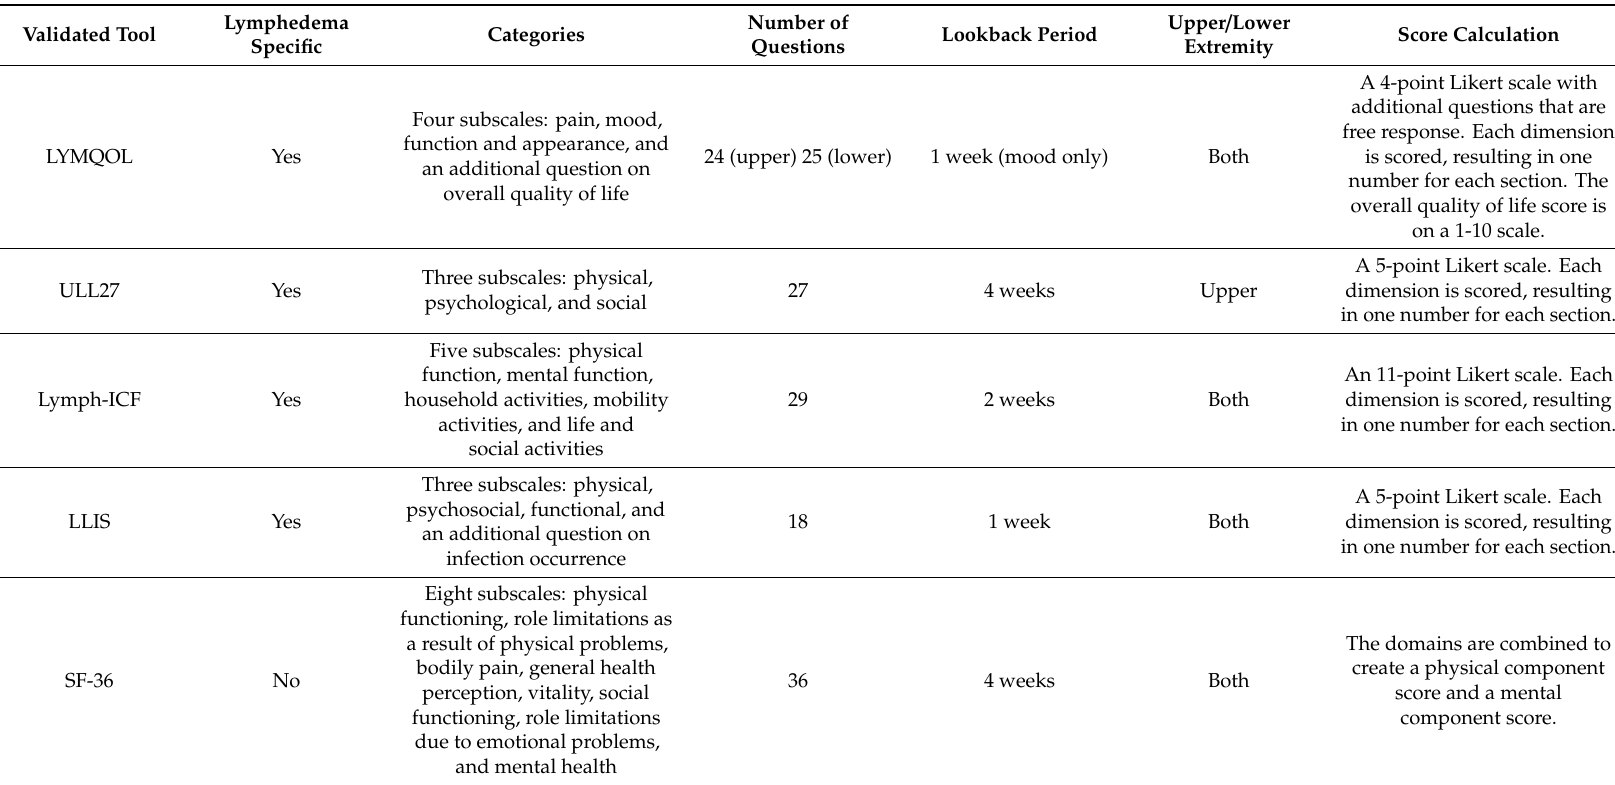
Table 1. Validated quality of life